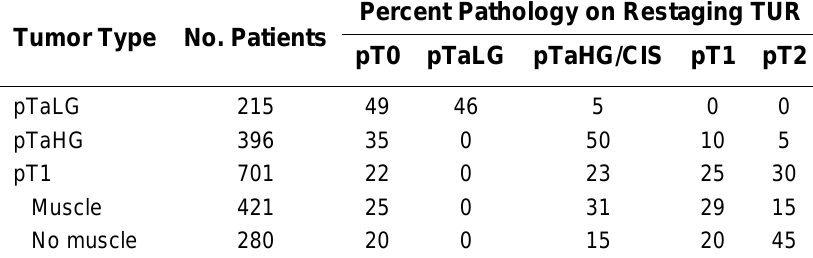
Restaging pTa and pT1 Bladder Tumors Percent Pathology on Restaging Tumor Type No. Patients